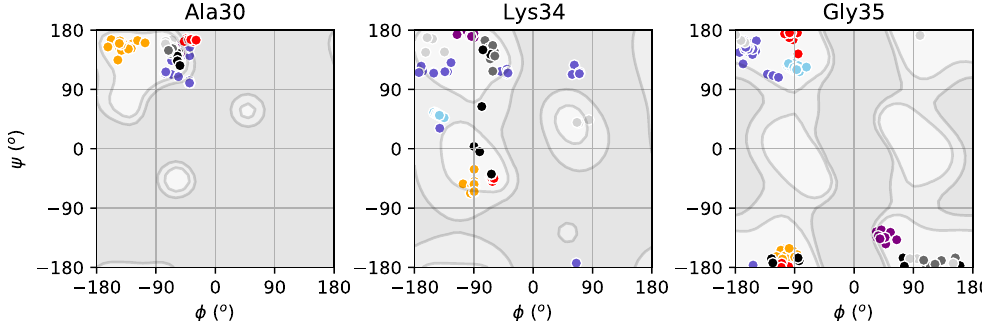
Figure 3. Ramachandran plot for selected linker residues. The ϕ and ψ values for Ala30 ( left ), Lys34 ( middle ) and Gly35 ( right ) are superposed to the probability distribution of the same residue in globular proteins taken from high-resolution structures in the PDB (https: // www.rcsb.org / ), where lighter shades of gray indicate a higher probability of occurrence. Ala30 is shown as a reference for poor variation in free NC. Backbone dihedral angles were calculated on the following PDB structures: 5l1R [105] (NCp7, grey, 21 conformers); 1A1T [59] (NCp7-SL3, sky blue, 25 conformers); 1F6U [60] (SL2-NC, slate blue, 20 conformers); 2L4L [61] (cTAR-NC, red, 10 conformers); 2JZW [58] (NCp7-PBS, orange, 19 conformers); 1BJ6 [93] (NCp7-d(ACGCC), purple, 10 conformers). The 21 conformers of 5I1R are further subdivided according to the definitions given in the original paper: cluster 1 (grey, ~40%), cluster 2 (dark grey, ~50%), cluster 3 (light grey, ~10%).